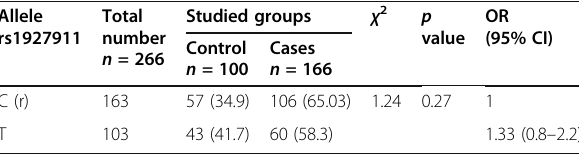
Table 10 rs1927911 allele polymorphism distribution between cases and control